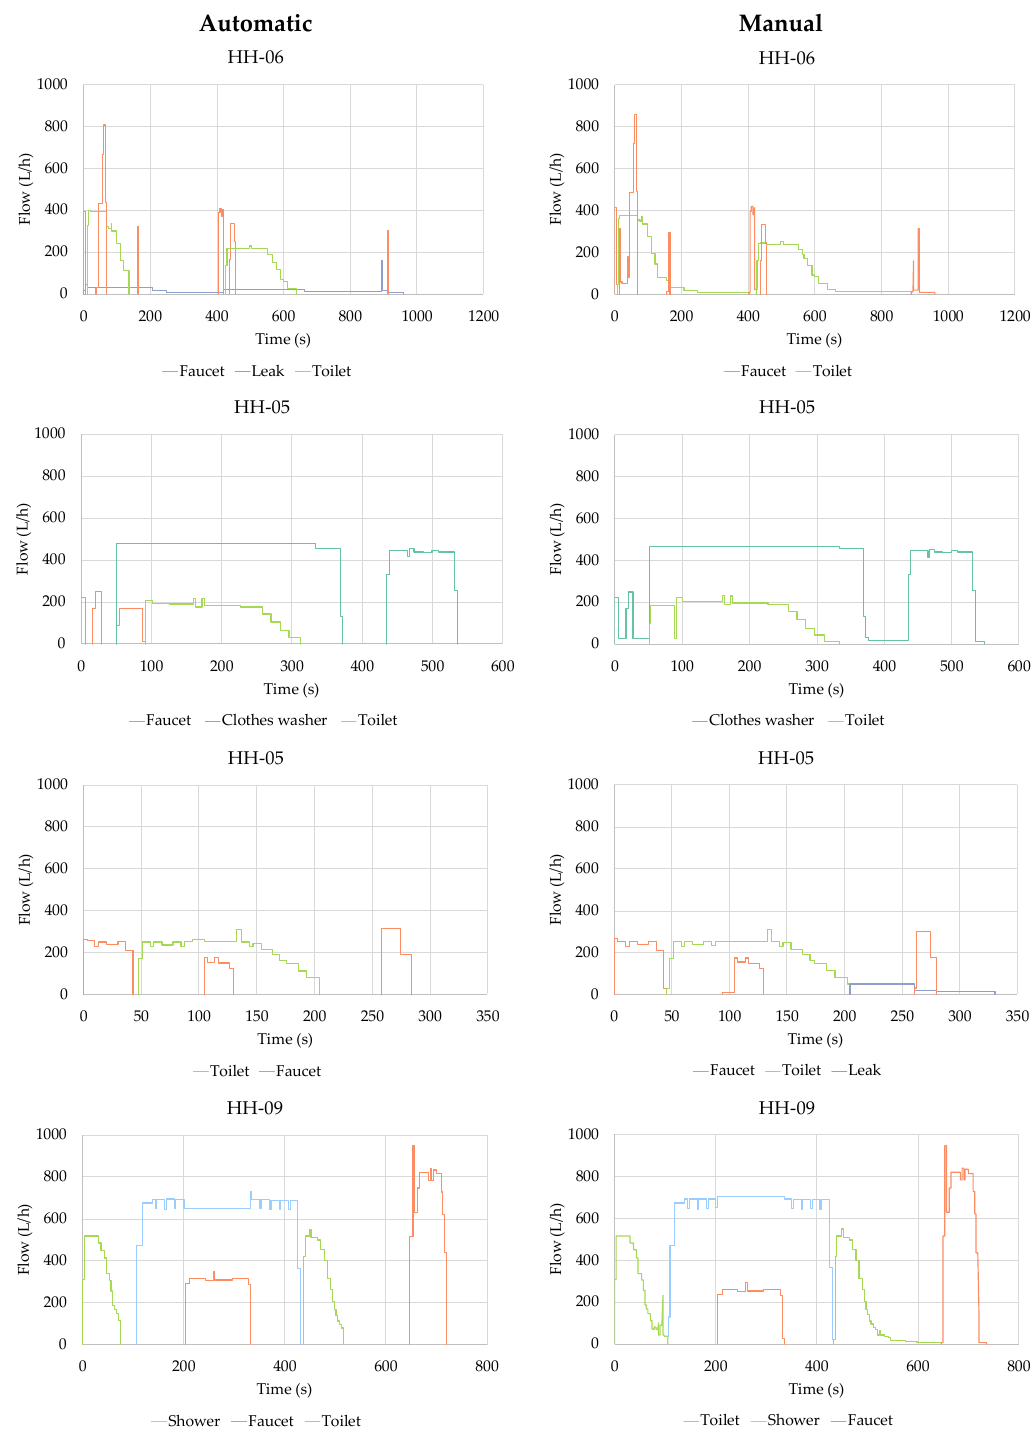
Figure A2 . Examples of Manual vs. Automatic Disaggregation from R1 study. Figure A2. Examples of Manual vs. Automatic Disaggregation from R1